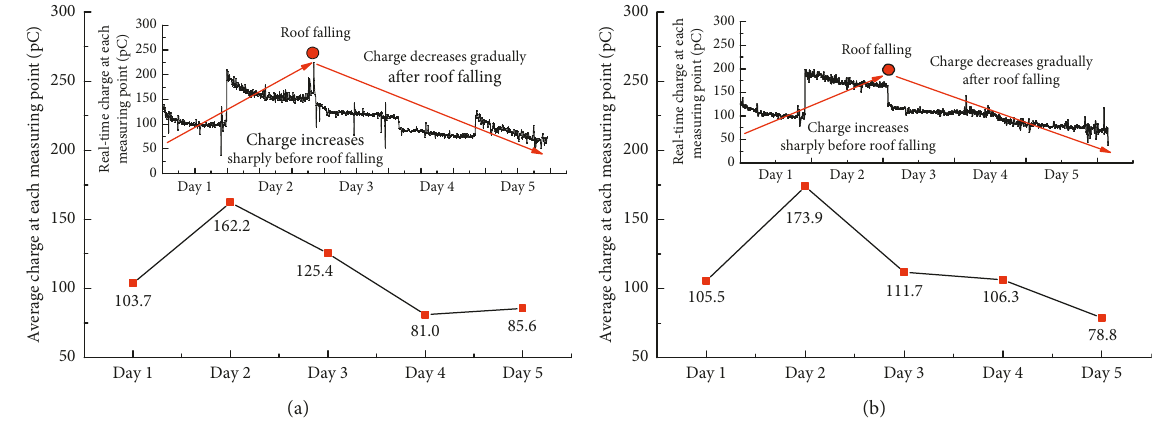
Figure 11: Variation of charge before and after roof falling at No. 5 and No. 6 measuring points. (a) No. 5 measuring points. (b) No. 6 measuring points.